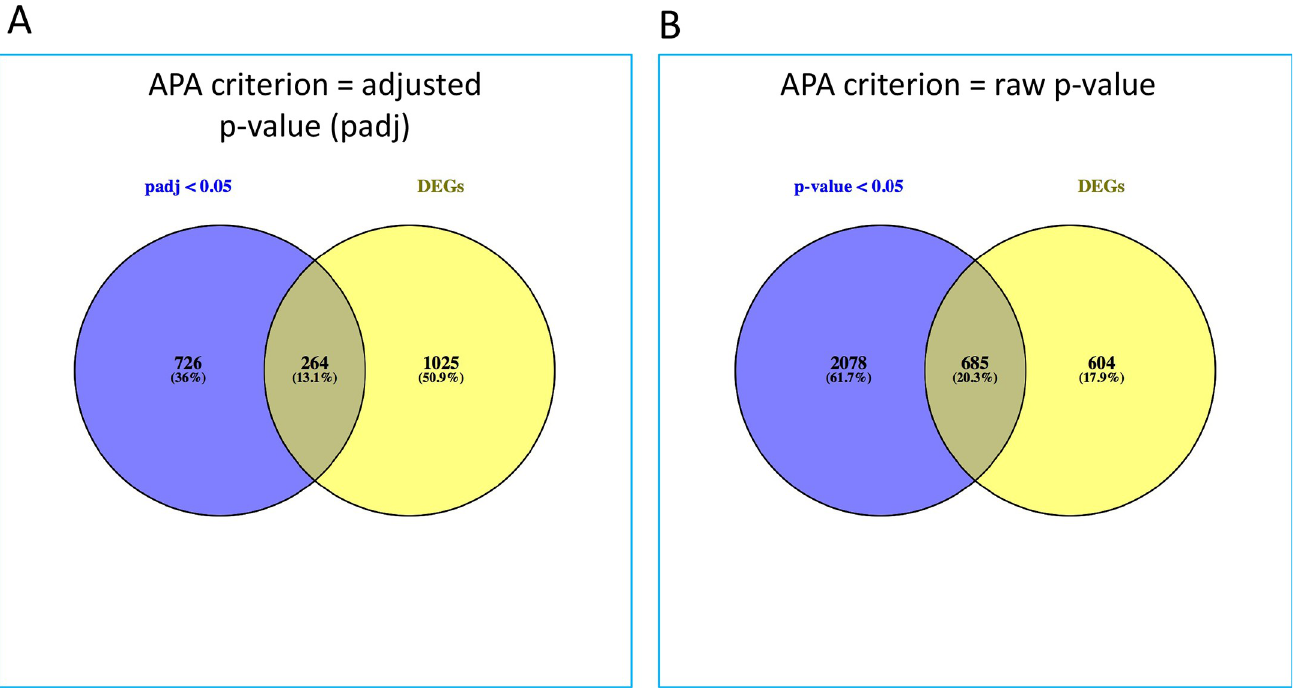
Fig 4. Genes that show differential poly(A) site usage and overall expression. Venn diagrams showing the overlaps between genes affected by APA (using the padj or p-value cutoffs described in the text, from S4 File; blue circles) and differentially expressed genes (from S3 File; yellow circles). Venn diagrams were made using Venny [20].